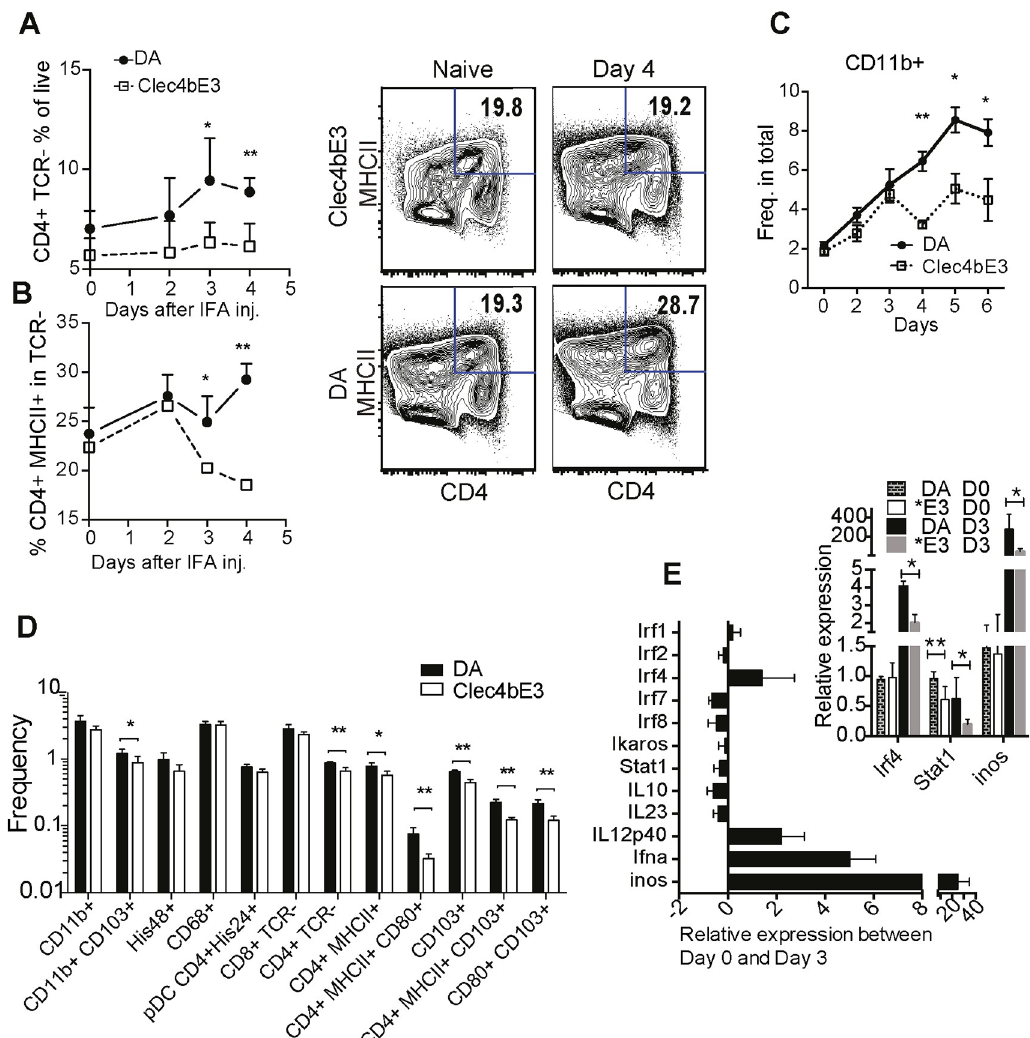
Fig 4. Clec4b is expressed in na ï ve CD4 + MHCII + DCs that expand greatly in Clec4b deficient rats after activation and initiate the development of inflammatory dendritic cells. a) The kinetic distribution of CD4 + DCs (of TCR - CD45+ cells) determined by flow cytometry in the spleen over time after IFA. n = 5 per group. Graph is a representation of 4 separate experiments. b) Kinetic distribution of geomean of fluorescence intensities of MHCII expression on CD4 + DCs over time after an intradermal IFA injection, and representative CD4 MHCII intensity plots for frequencies for samples from day 0, and day 4 after oil injection. Previously gated for TCR - CD45 + cells. c) CD11b expression on TCR - OX33 - MHCII + cell as frequencies of total cells ( n = 5 per group). d) The distribution of DC subsets in spleen day 3 after oil injection. The displayed distribution is for total cells and is a representative sample from 3 separate experiments ( n = 5 per group). e) The relative expression of DC activation/ differentiation regulating genes in the immune-precipitated CD4+ TCR- cells comparing expression day 0 to Day 3. Larger graph illustrates expression for both DA and Clec4b E3 . Data from the two genotypes were pooled to give a general overview. The smaller upper graph describes relative gene expression for genes that were differentially expressed between DA and Clec4b E3 . Significance stars depict Mann. Whitney Test � = p < 0 . 05 , �� = p < 0 . 01 bars are for SEM ( n = 5 per group).